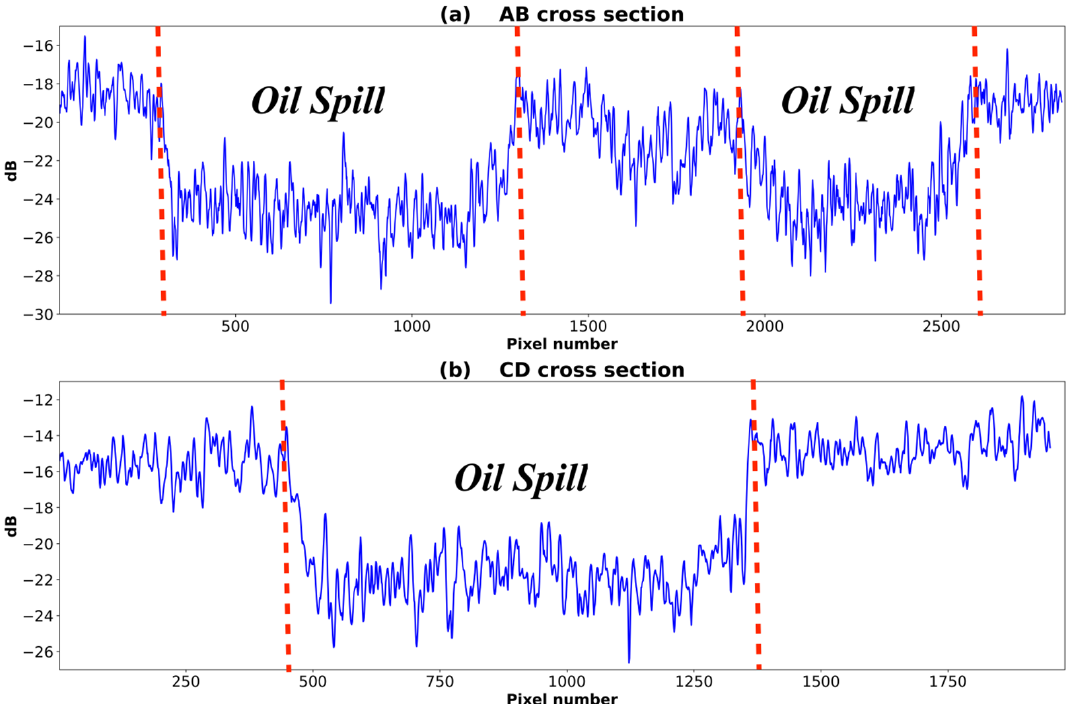
Figure 4. The intensity of the radar backscattering ( Y ‐ axis) at each pixel ( X ‐ axis) along the cross ‐ sections ( a ) AB and ( b ) CD (shown in Figure 3a) from Sentinel ‐ 1 SAR images on 13 October 2019 (two days after the spill). The pixel numbers with low/high intensity values are associated with